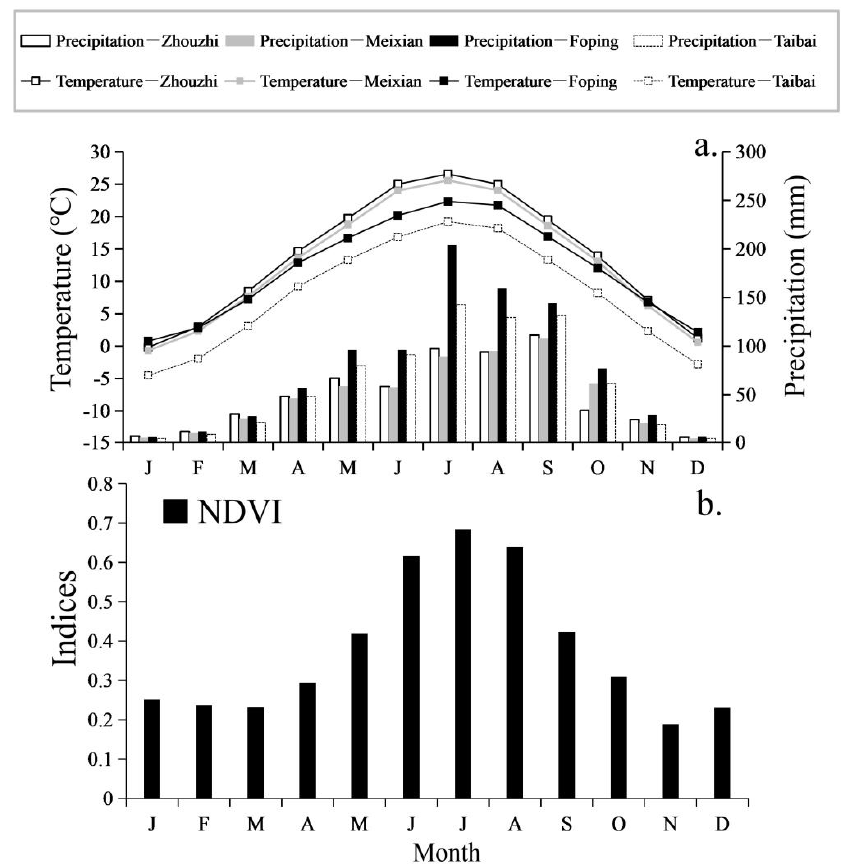
Figure 3. Monthly variation of mean air temperature and total precipitation for Foping,